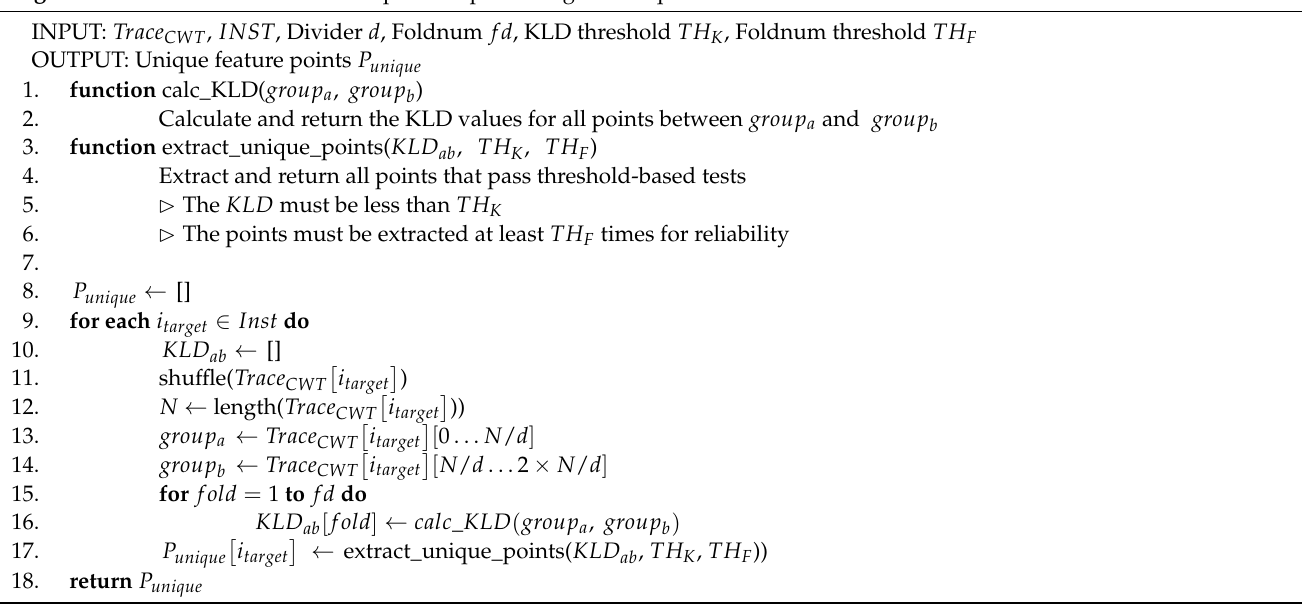
Algorithm 1 Extraction of the feature points representing the unique characteristics of each instruction